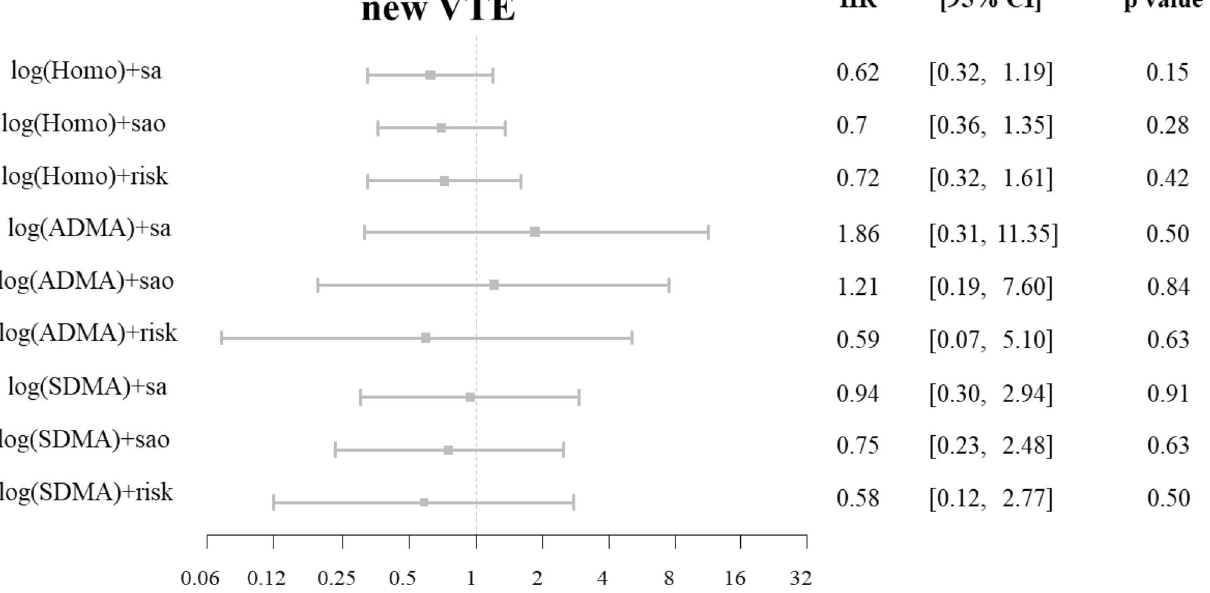
Figure 3. Homoarginine, ADMA, SDMA and the risk of new VTE in the patients with confirmed VTE (cases). Cox regression analysis. Adjustment for sex and age (‘sa’), sex, age and OAC (‘sao’) and for sex, age, OAC, BMI, arterial hypertension, diabetes mellitus, smoking, dyslipidemia, chronic heart failure, history of stroke, creatinine and cancer (‘risk’). ‘new VTE’ encompasses recurrent DVT and/or recurrent PE. Homo, homoarginine; ADMA, asymmetric dimethylarginine; SDMA, symmetric dimethylarginine; VTE, venous thromboembolism; OAC, oral anticoagulation; BMI, body mass index; DVT, deep vein thrombosis; PE, pulmonary embolism; HR, hazard ratio; CI, confidence